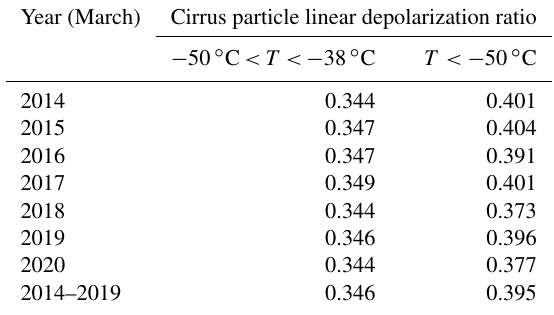
Table 3. Medians of the cirrus particle linear depolarization ratio determined at warmer ( − 50 ◦ C <T < − 38 ◦ C) and colder tempera- tures ( T < − 50 ◦ C), respectively, in March of the years